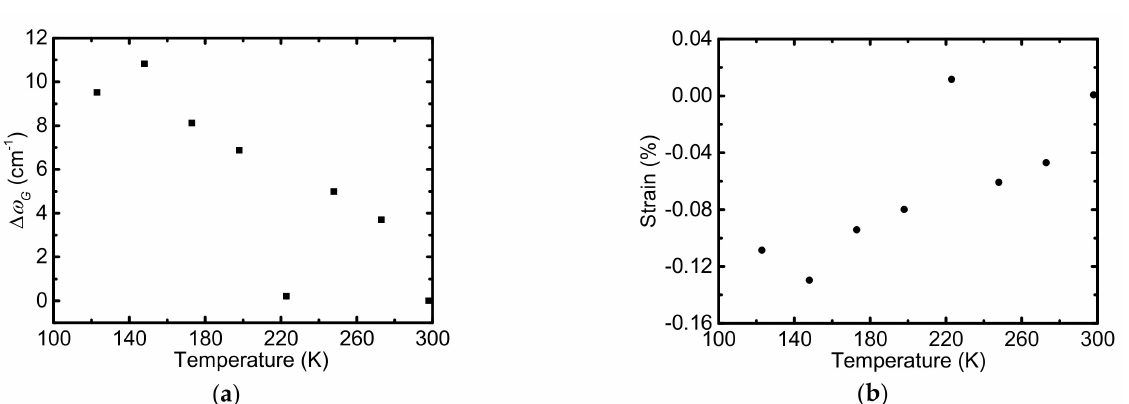
Figure 6. ( a ) Frequency shift of the G band of SLG supported by PMMA. ( b ) Temperature dependence of the strain buildup in graphene due to the TEC mismatch between graphene and